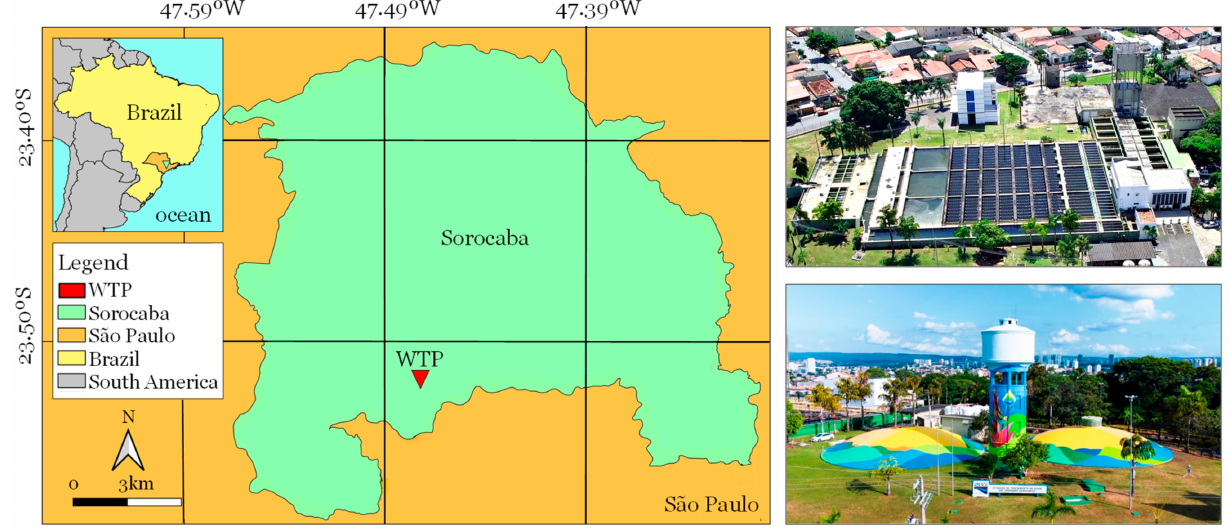
Figure 1. Drinking water treatment plant—WTP Cerrado at Sorocaba city, S ã o Paulo State, southwest, Brazil. Source: modified from Santinon [36].